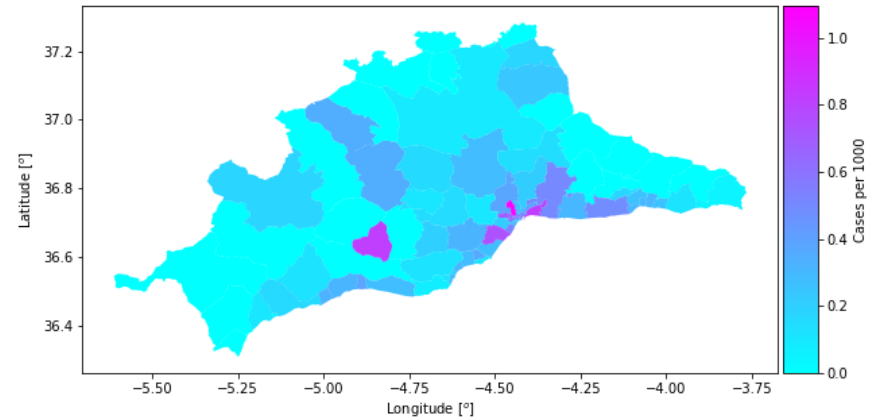
Figure 4. Density of cases in the